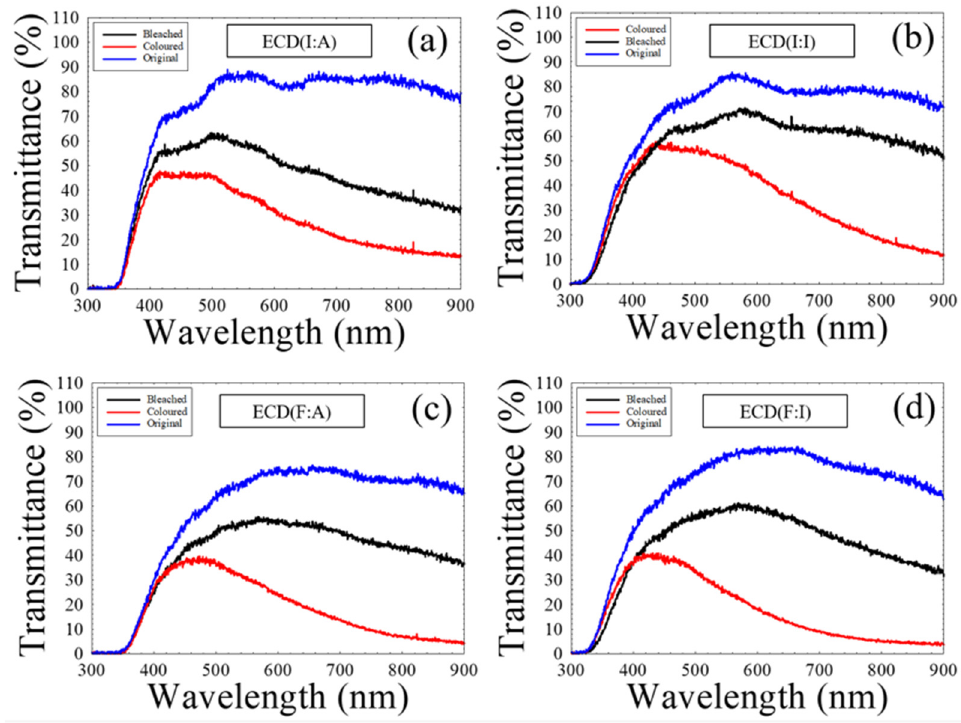
Figure 4. The original, coloring, and bleaching transmittances of ( a ) ECD(I:A), ( b ) ECD(I:I), ( c ) ECD(F:A), and ( d ) ECD(F:I).